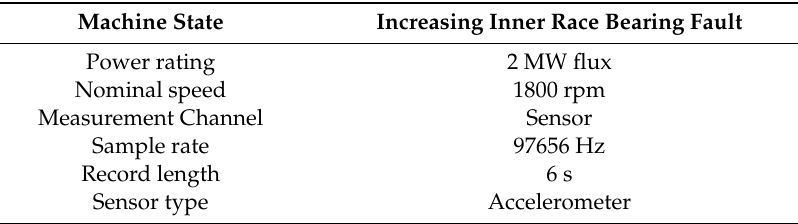
Table 1. Wind turbine operating details.